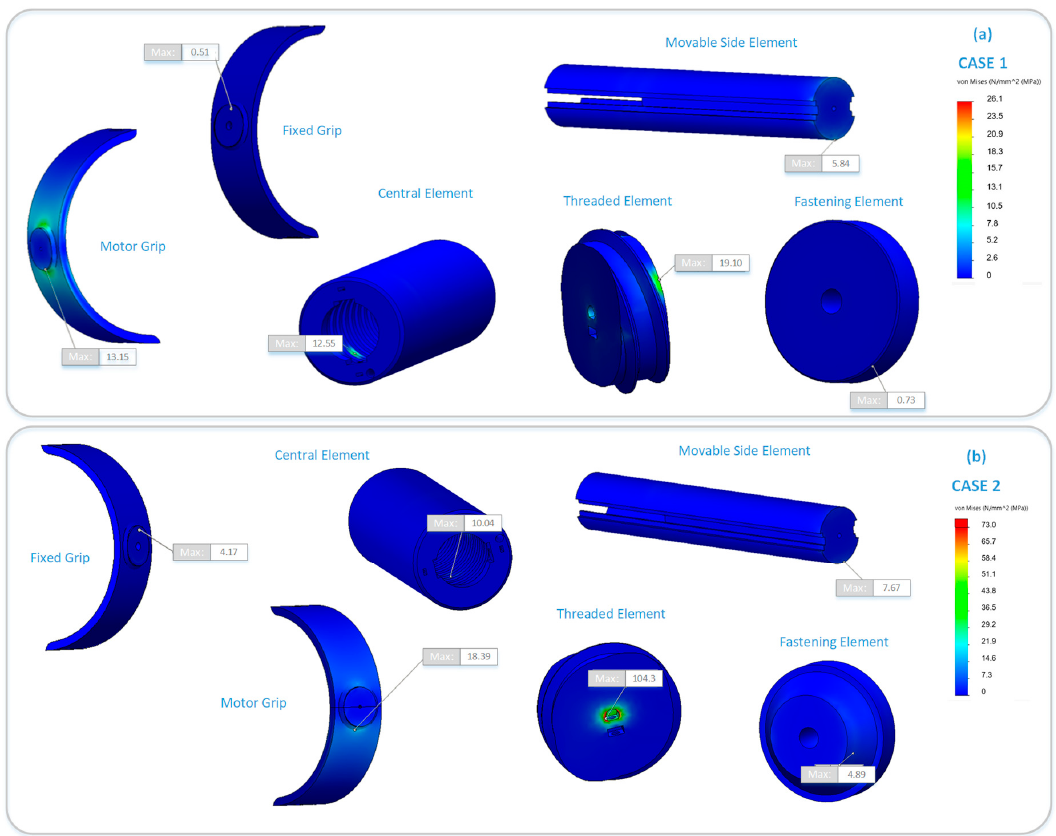
Figure 16. Distribution of von Mises stress in the mechanical components: ( a ) Load Case 1—axial force; ( b ) Load Case 2—eccentric force.